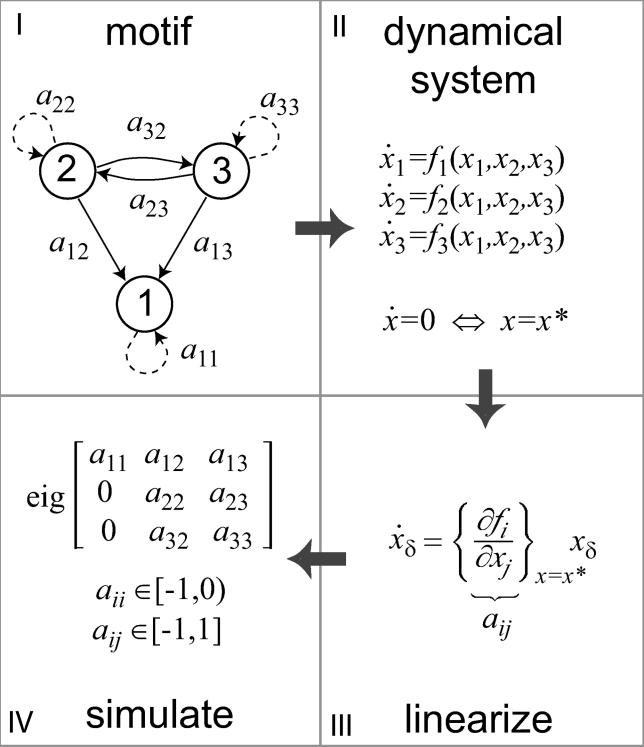
Scheme for Modeling the Local Stability of a Network Motif(I) An example network motif (10) depicted with nodes and edges labeled. The sign and weight of an edge from node j to node i is denoted aij (solid line) consistent with the notation in the rest of the figure. Additionally, we assume that every node may have a self-interaction aii (dotted line).(II) A motif is a graphical depiction of a dynamical system that can be modeled using (possibly nonlinear) ordinary differential equations, which are functions of the state of the nodes in the motif.(III) Assuming that the motif can achieve steady-state dynamics, the stability of the equilibrium may be analyzed by making a linear approximation of the (possibly nonlinear) functions. Linearization involves computation of the Jacobian, a matrix of partial derivatives of the functional dependencies expressed in the equations with respect to the variables. The linearized system is evaluated at the equilibrium point(s), resulting in specific values of aij.(IV) The general form of the Jacobian matrix corresponding to this motif contains zero entries wherever one node exerts no influence on another node and non-zero elements wherever it does. An instance of a Jacobian consistent with the corresponding motif is created by sampling the non-zero terms from some distribution. Eigenvalues of the Jacobian indicate the local stability properties of the equilibrium point. Sampling many instances of structurally equivalent Jacobians allows computation of the probability of stability of an equilibrium point.